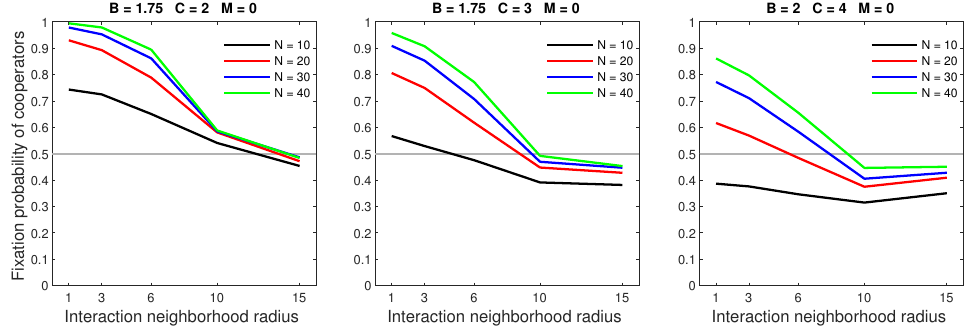
Figure 1. Increasing the population density raises the fixation probability of cooperators. The left pane represents the cooperator’s ideal condition with the highest benefits of cooperation paired with the lowest cooperation cost. The right pane represents their least favorable condition with the lowest benefits and highest